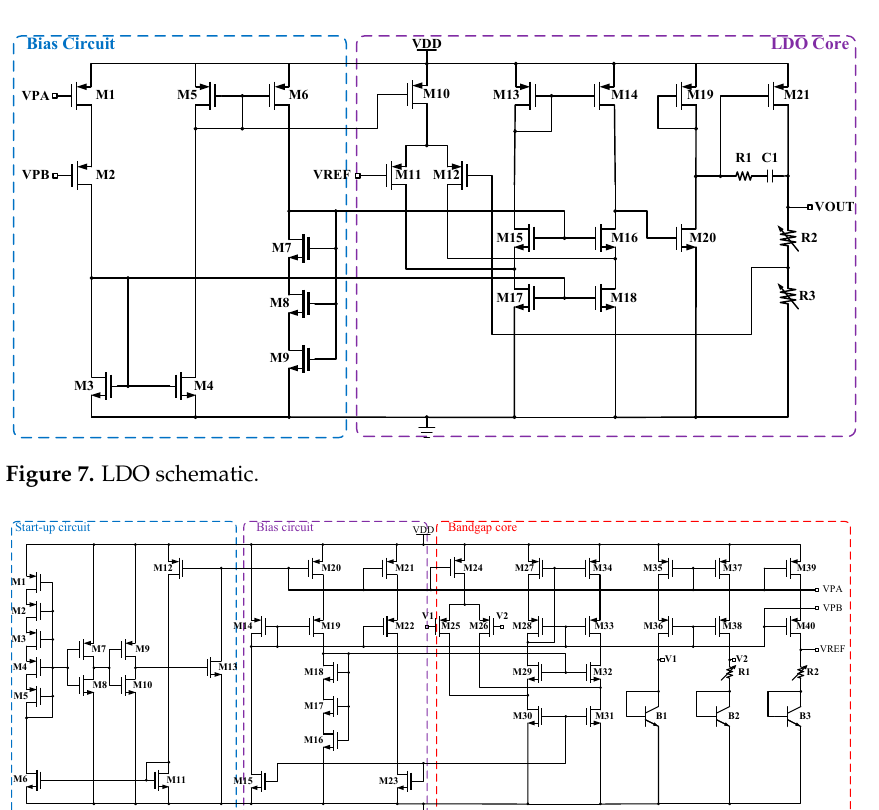
PMU adopts a traditional bandgap and low dropout regulator (LDO) topology as depicted in Figures 7 and 8. PMU works under a 2.5 V power supply while the LDO outputs a stable 2 V power supply. An on-chip 10-bit resistor string trimming is designed with the help of SPI control. The post-simulated bandgap voltage reference is around 1.12 V and its current reference is around 10 μ A.